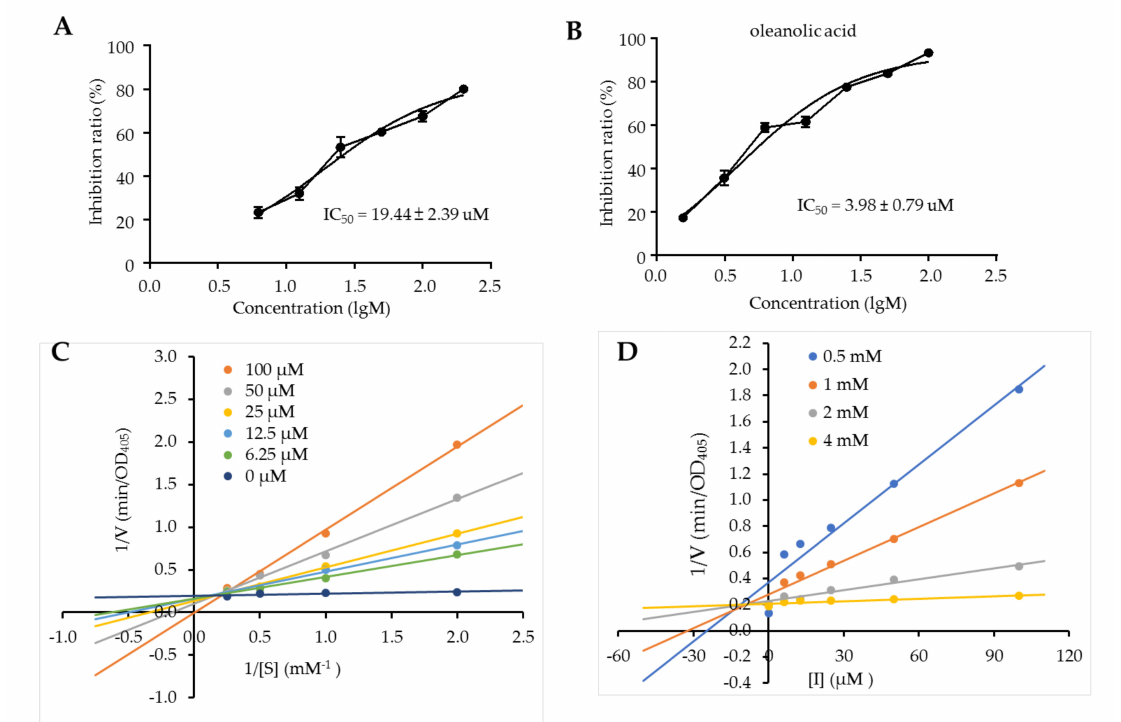
Figure 2. Protein-tyrosine phosphatase 1B (PTP1B) inhibitory activity and kinetic analysis for compound 1 . Concentration—PTP1B inhibition ratio curves of compound 1 ( A ) and the positive control oleanolic acid ( B ). ( C ) Lineweaver-Burk plot for the inhibition of PTP1B by compound 1 . ( D ) Dixon plot for the inhibition of the PTP1B by compound 1 . Data are expressed as mean ± SD, n =